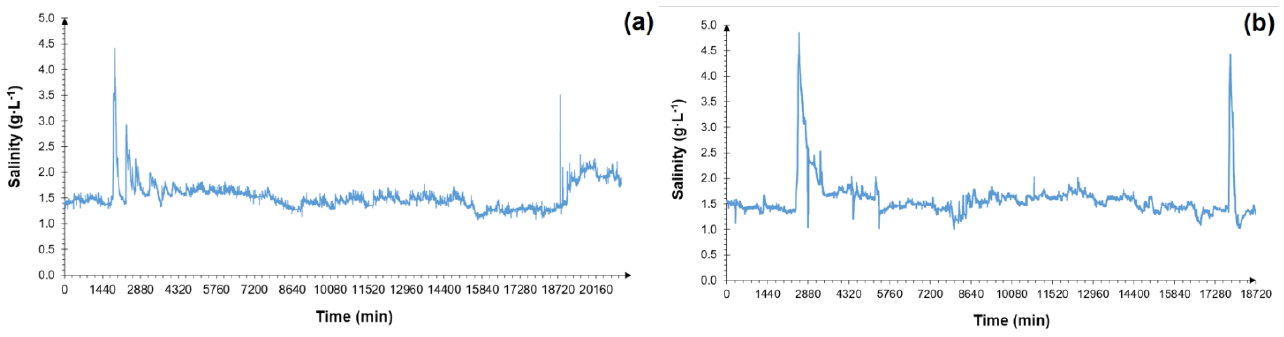
Figure 6. Changes in the NaCl concentration in the septic tank outflow ( a ) between 13 and 27 January and ( b ) between 31 May and 14 June.